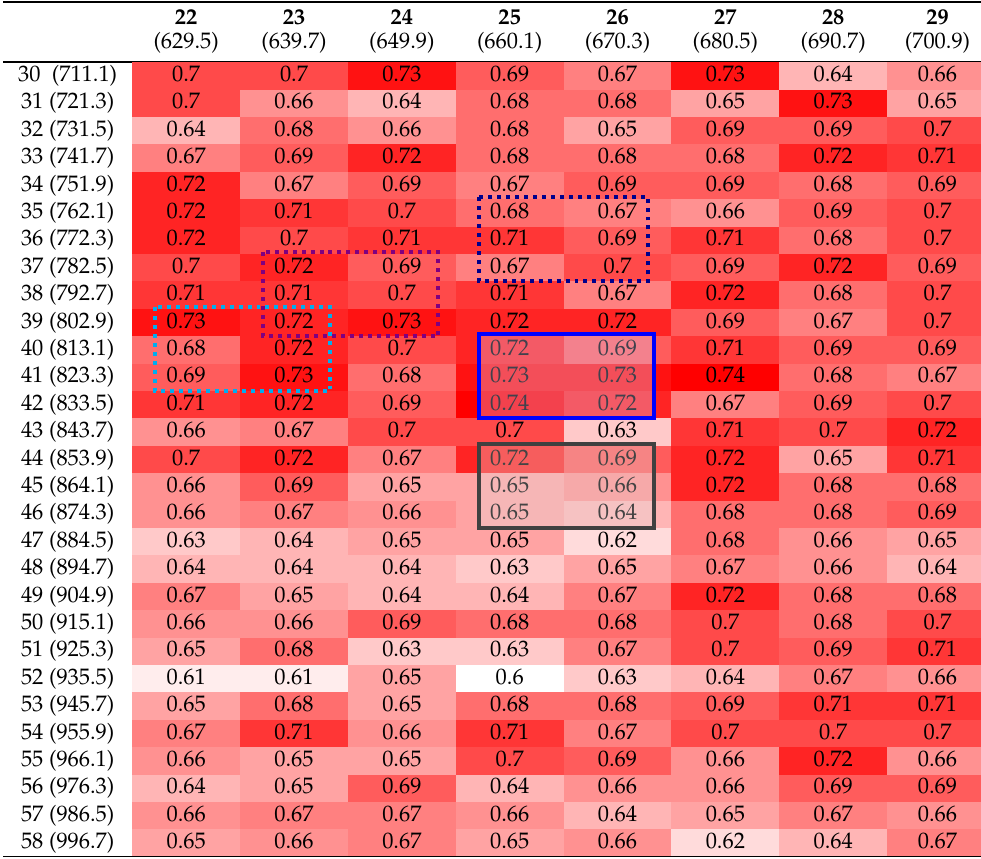
Table 2. Accuracy results for each red/NIR band combination, derived using the TP/FP inv metric. The cell values represent the total accuracy of all 56 input scenes. The colored rectangles indicate the optimal wavelengths for burnt area detection according to different metrics, while the black rectangle marks the region of the Sentinel-3 OLCI bands used in the DLR-GZS wildfire monitoring